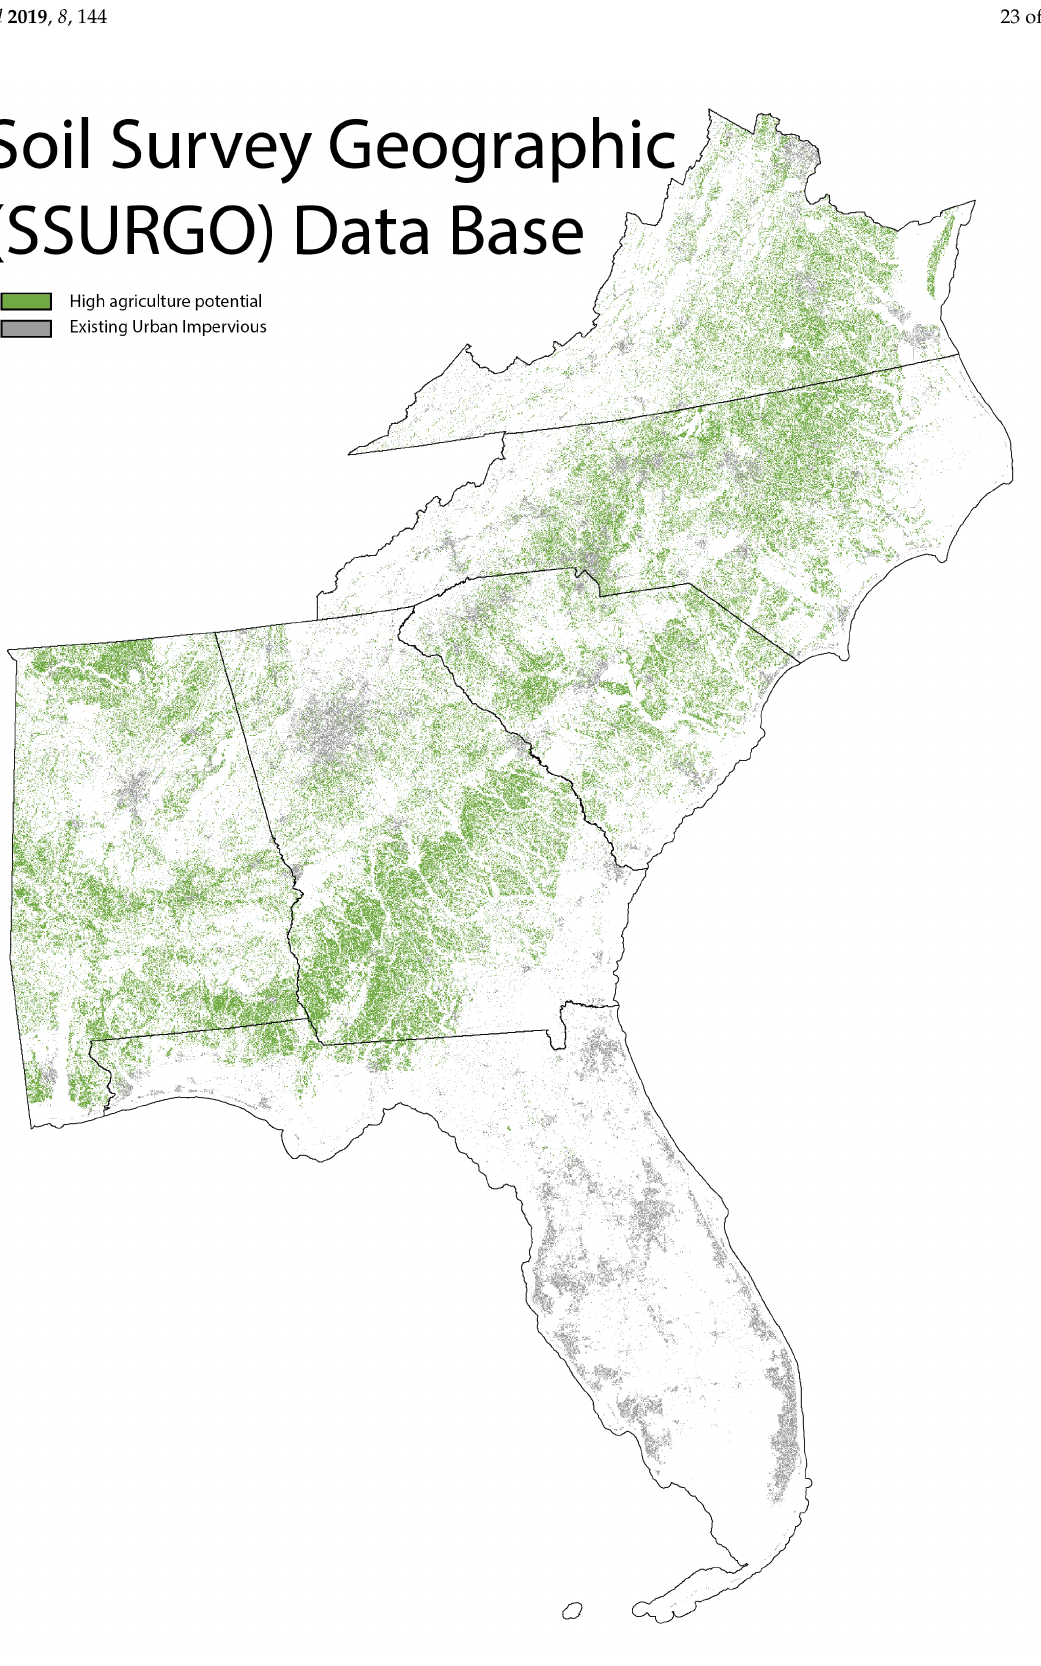
Figure A5. Agricultural suitability data